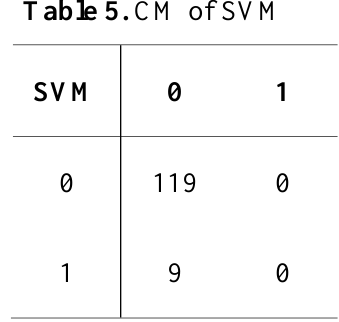
Table 6. CM of KNN Table 7. CM of Logistic Regression Table 8. CM of Naïve